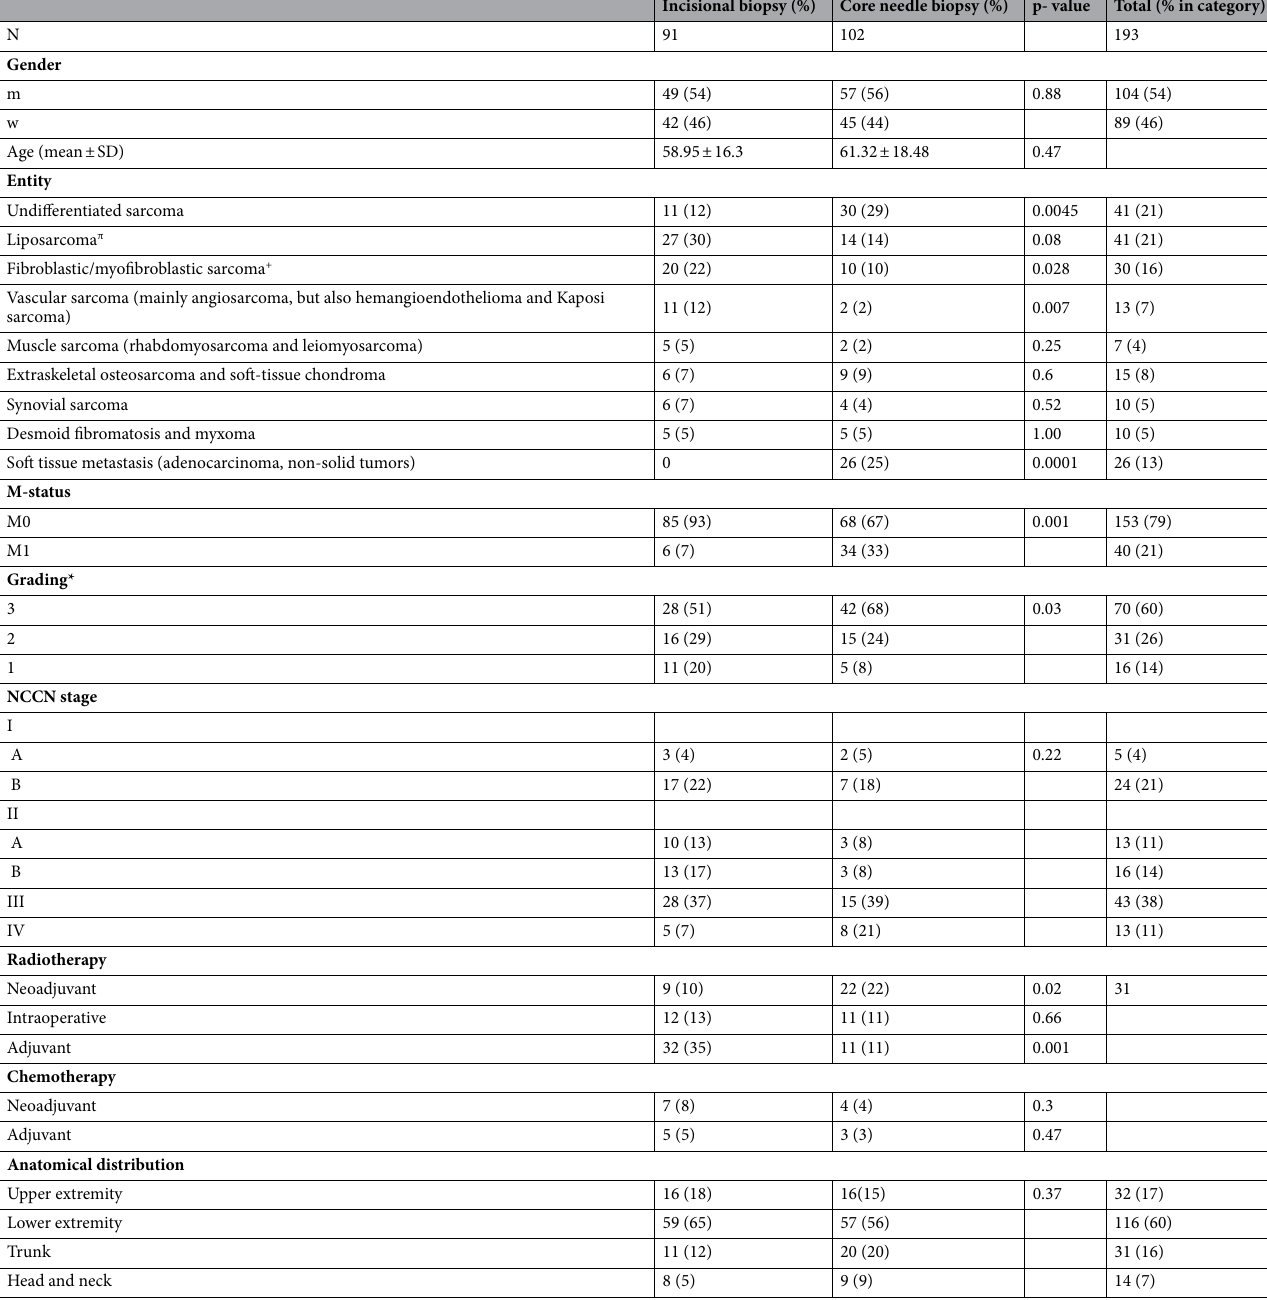
Table 1. Overview of patients included in the study. π Includes tumors classified as “round cell” before the 2013 Classification; + includes dermatofibrosarcoma protuberans, malignant solitary fibrous tumor, malignant fibrous histiocytoma (entity removed from the classification in the 2013 WHO Classification of Tumors of Soft Tissue); *on biopsy, not attempted on all specimens, not reported for specimens that have undergone neo- adjuvant irradiation, and not reported for non-sarcoma